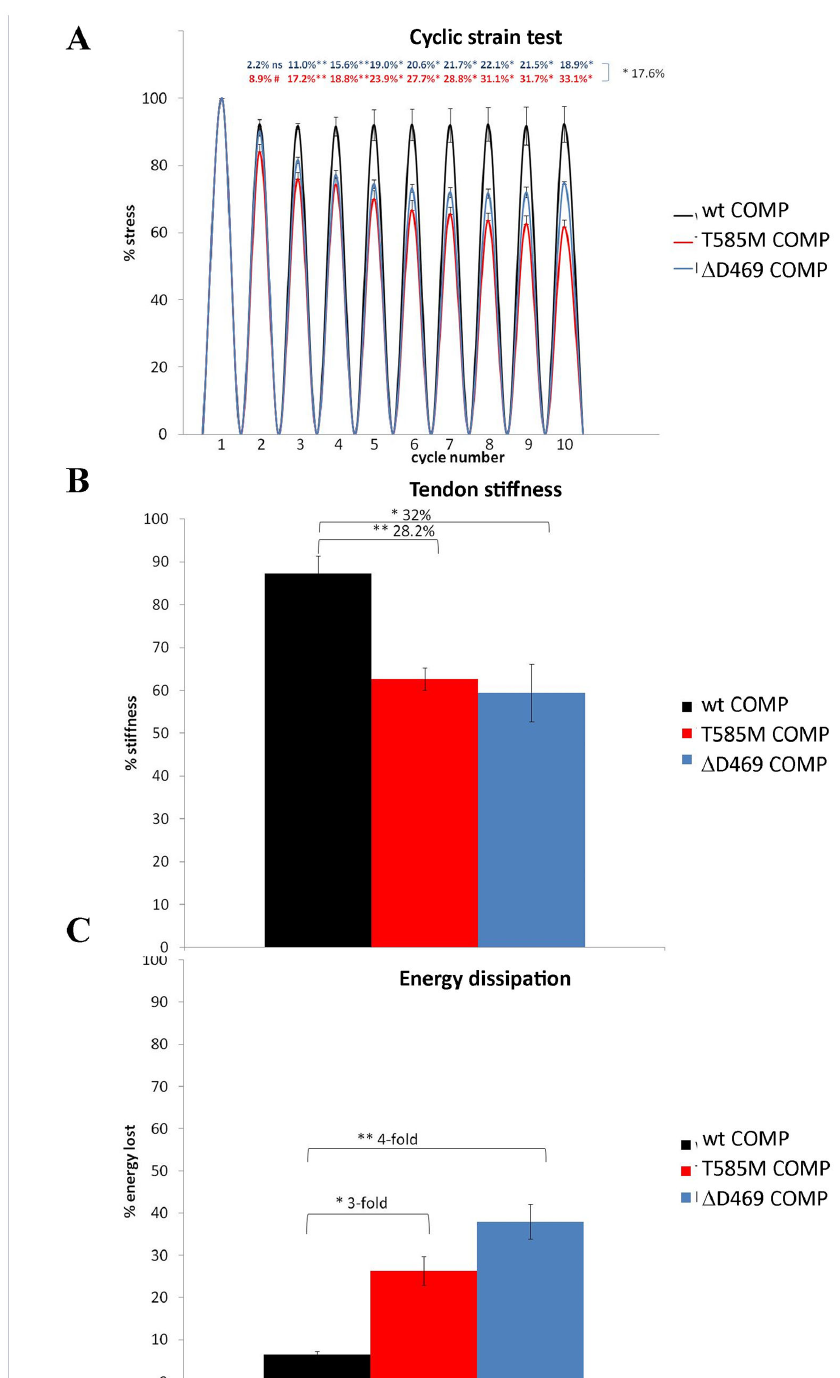
Figure 6. Results of the cyclic test experiment on COMP mutant tendons. A ) Stress per cycle plot showing a decrease in force needed to extend mutant tendons to the same strain as the wild type controls. Note that although both COMP mutant tendons became more lax in cyclic testing, the ΔD469 COMP tendons become slightly less lax than the T585M COMP tissue by 10 th cycle. B ) Calculation of the proportion of energy dissipated by the Achilles tendons in 10th cycle, showing the mutant COMP tendons may potentially fail as energy storage and buffering elements in mutant hind limbs. C ) Tendon stiffness at 10 th cycle calculated in relation to stiffness at cycle 1 (100%) showing mutant COMP tendons becoming more lax than the wild type controls. Error bars; SEM (standard error of the mean; n≥3). Key: * P<0.05, ** P<0.01, *** P<0.001. doi: 10.1371/journal.pone.0082412.g006 PLOS ONE |